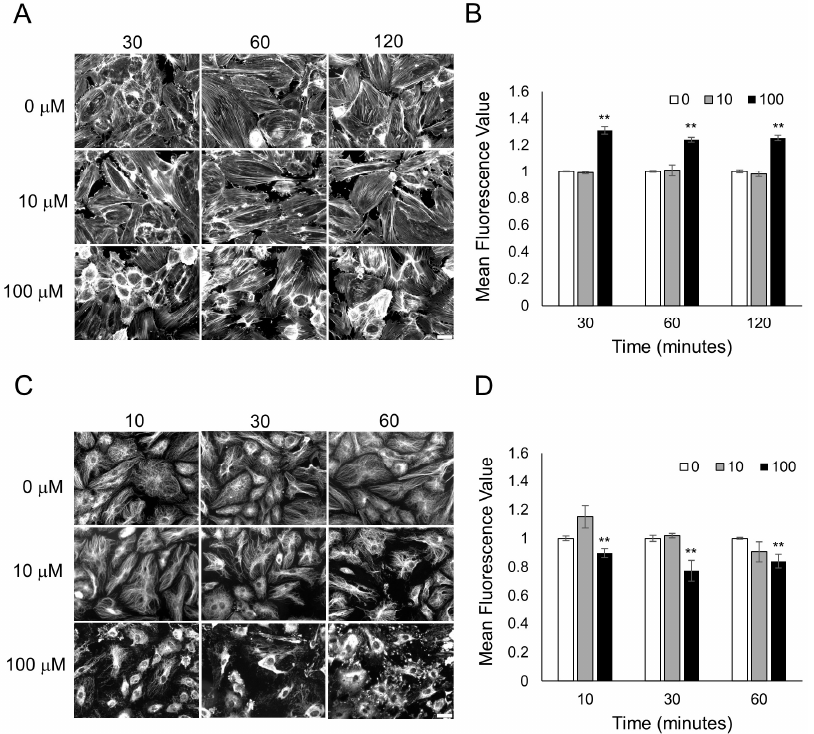
Figure 4. Lyral exposure causes F-actin assembly and microtubule disassembly in HUVECs. Fluores- cent images of F-actin phalloidin staining ( A ) and tubulin staining ( C ) after HUVECs were treated with 0, 10, 100 µ M lyral for 10–120 min. Scale bar = 50 µ m. Quantitative mean fluorescence intensity of F-actin staining ( B ) and tubulin staining ( D ) was measured using Fiji. A two-tailed t -test was performed to compare each lyral-treated group to the control group completed at the same time point; ** p < 0.01 as